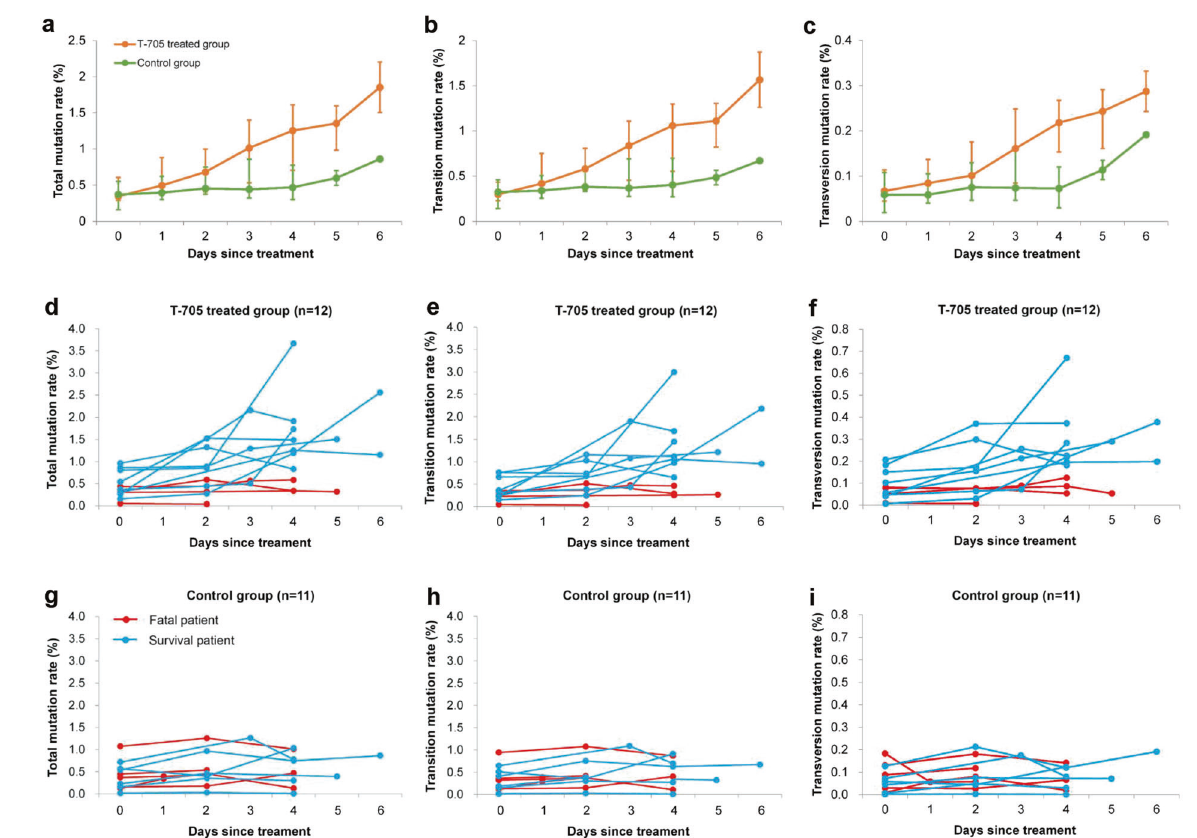
Fig. 8 The kinetics of the viral mutation in SFTS patients. A total of 40 samples were obtained from 12 patients receiving T-705 treatment (4 fatal and 8 survival) and 34 samples were obtained from 11 controls (5 fatal and 6 survival). The mean total mutation rates, transition mutation rates, and transversion rates, and ratio of transitions/transversions are shown over time for the two groups ( a , b , c ). The daily value of total mutation rate, transition mutation rate, and transversion rate was shown over time for each patient in the T-705 treated group ( d , e , f ) and the control group ( g , h , i )